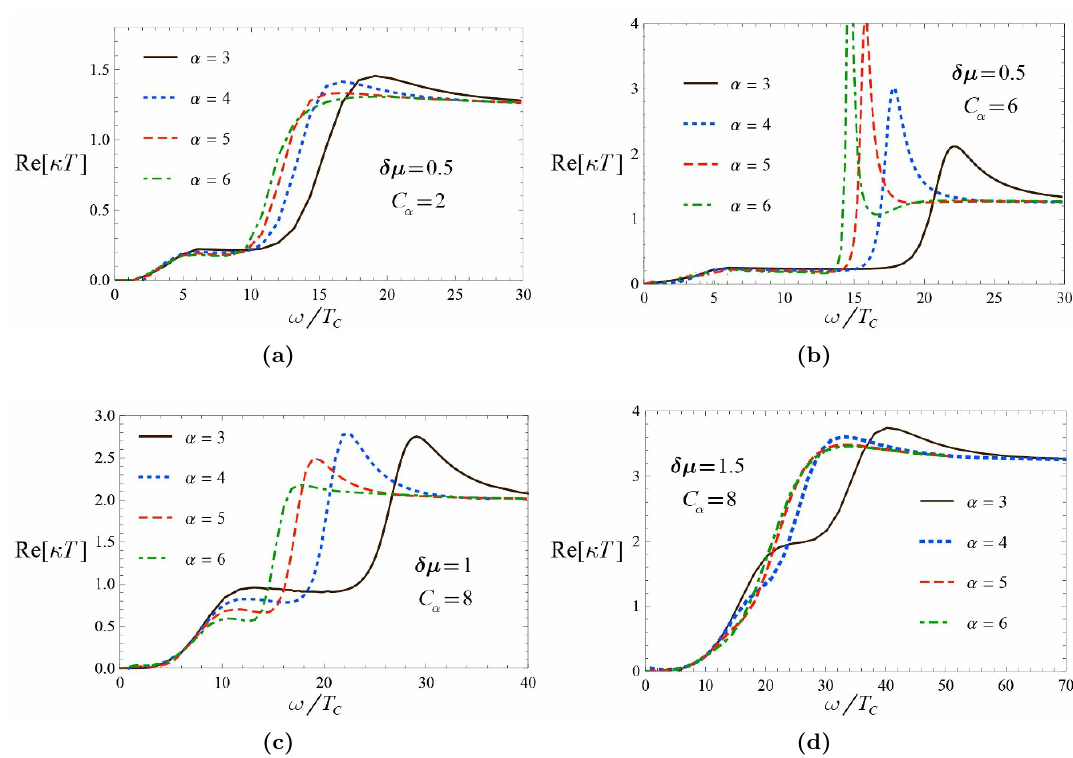
Figure 22. The real part of the thermal conductivity in terms of !=T c for the function F ( ) = 2 + C (cid:11) with (cid:11) = 3 ; 4 ; 5 ; 6 (solid curve, dotted curve, dashed curve, and dot-dashed (cid:11)